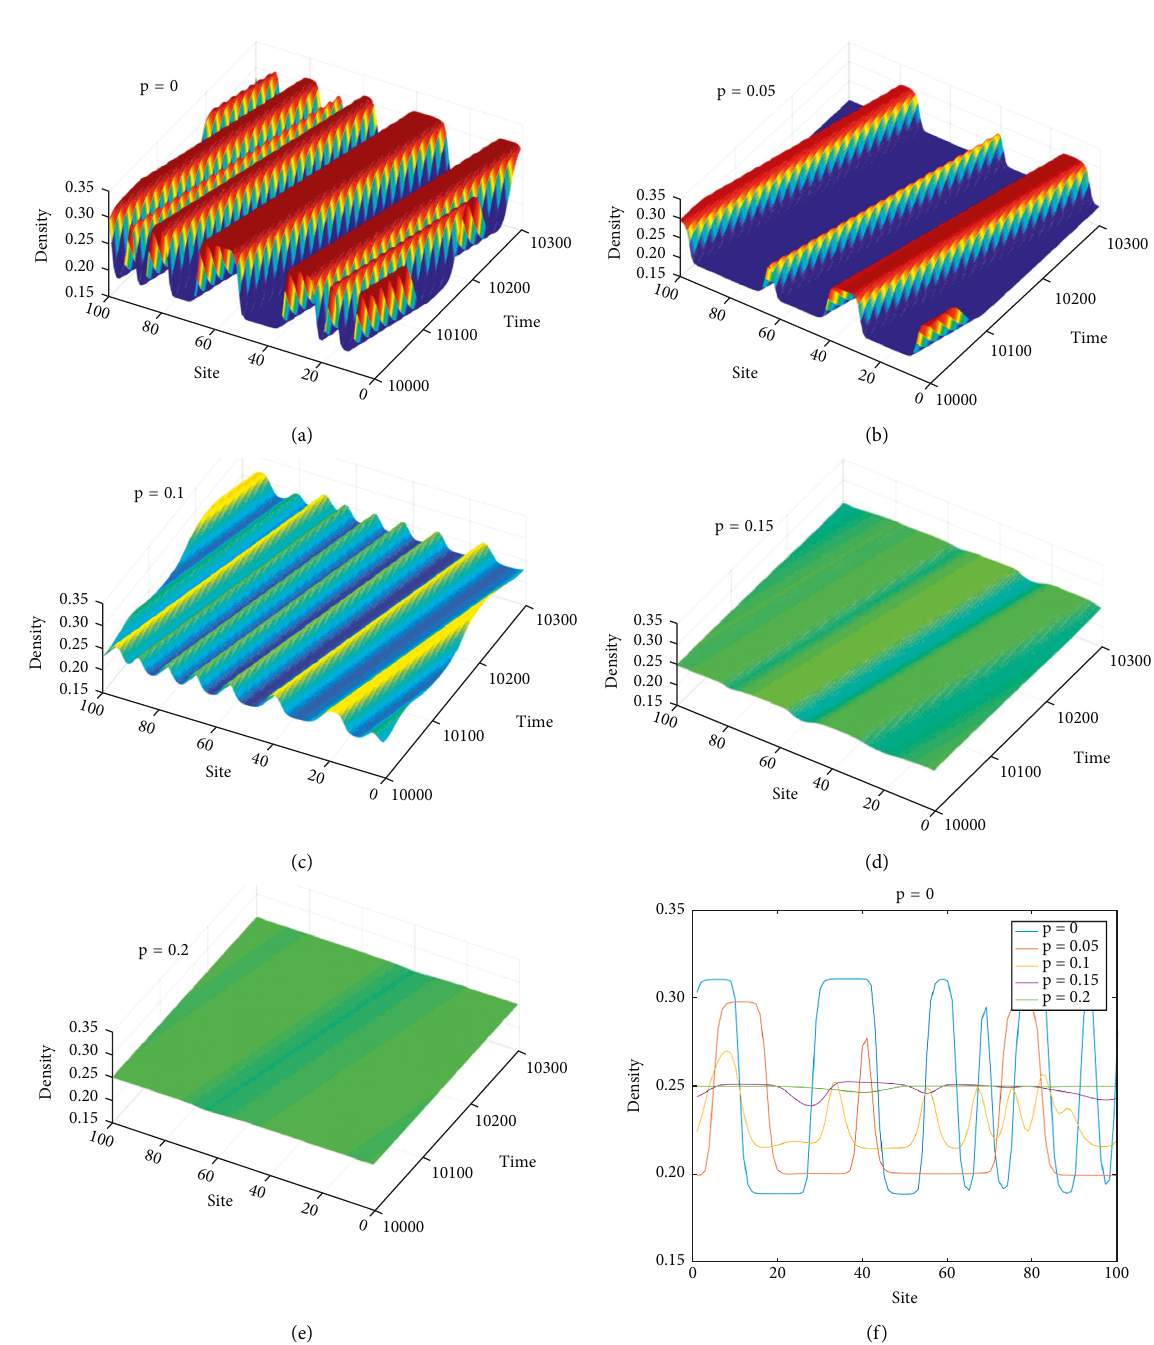
Figure 2: Spatiotemporal evolution of the density wave and cross-section view of the density wave with time under the action of different p . (a) p � 0. (b) p � 0.05. (c) p � 0.1. (d) p � 0.15. (e) p � 0.2. (f) p � 0.